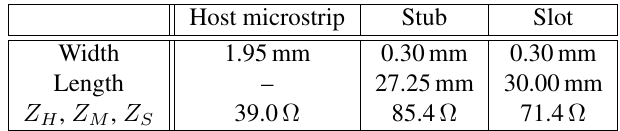
Table 1: Summary of the design geometric parameters and characteristic impedances @ 4 GHz.